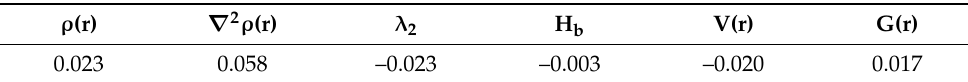
Figure 2. Laplacian of electron density distribution ∇ 2 ρ ( r ), visualization of electron localization function (ELF), and reduced density gradient (RDG) analyses (left, center, and right diagrams, respectively) for aurophilic interactions Au(I) ··· Au(I) in the X-ray structure 4 . Bond critical points (3, –1)—blue, nuclear critical points (3, –3)—pale brown, ring critical points (3, +1)—orange, bond paths—pale brown lines, length units—Å; the color scale for the ELF and RDG maps is presented in a.u. The bond critical point (3, –1) for aurophilic interactions Au(I) ··· Au(I) is indicated by black arrow in left diagram; the blue area of reduced density gradient, very typical for noncovalent interactions, is indicated by black ellipse in right diagram. Table 1. The density of all electrons, ρ ( r ); Laplacian of electron density, ∇ 2 ρ ( r ); appropriate λ 2 eigenvalue; energy density, H b ; potential energy density, V( r ); and Lagrangian kinetic energy, G( r ) (a.u.) at the bond critical point (3, –1) corresponding to aurophilic interactions Au(I) ··· Au(I) in the X-ray structure of 4